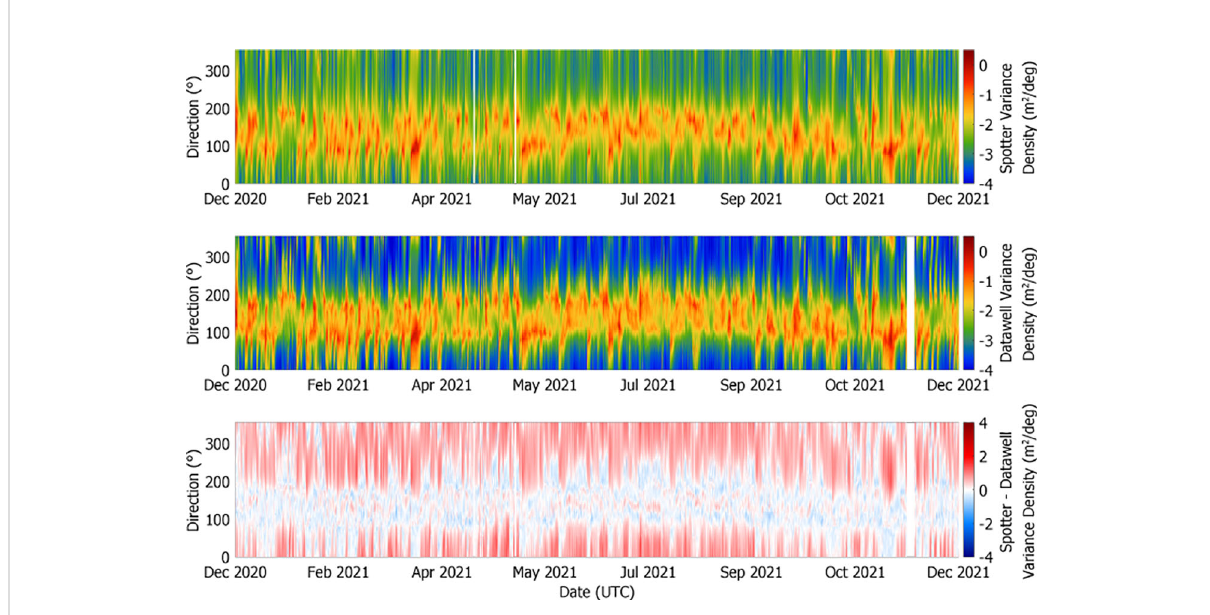
FIGURE 7 Time series displaying wave energy against direction recorded by the Spotter (top) and Datawell (center) wave buoys on a log scale.